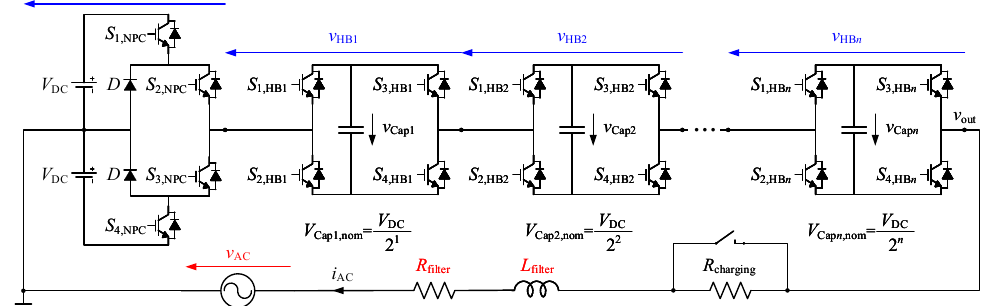
Figure 1. Grid-connected, single-phase asymmetric MLC arrangement, using an NPC module as main stage and n series-connected H-bridges, with charging resistor R charging